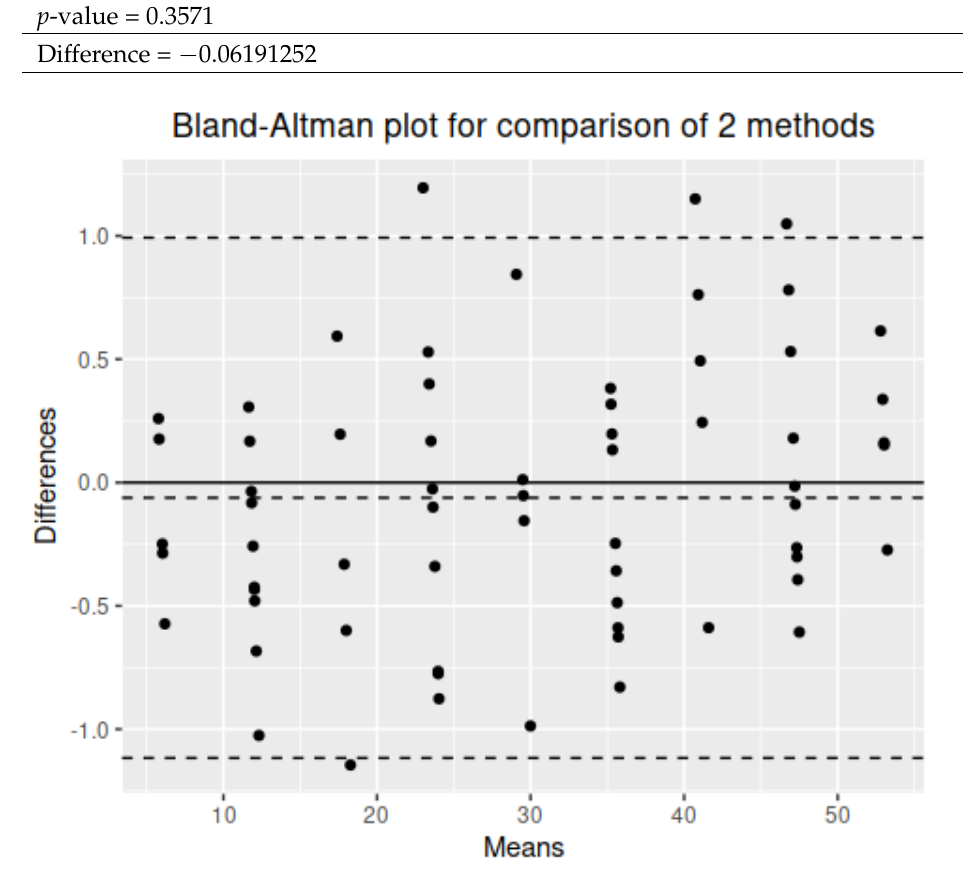
Figure 16. Bland–Altman plot for experiment